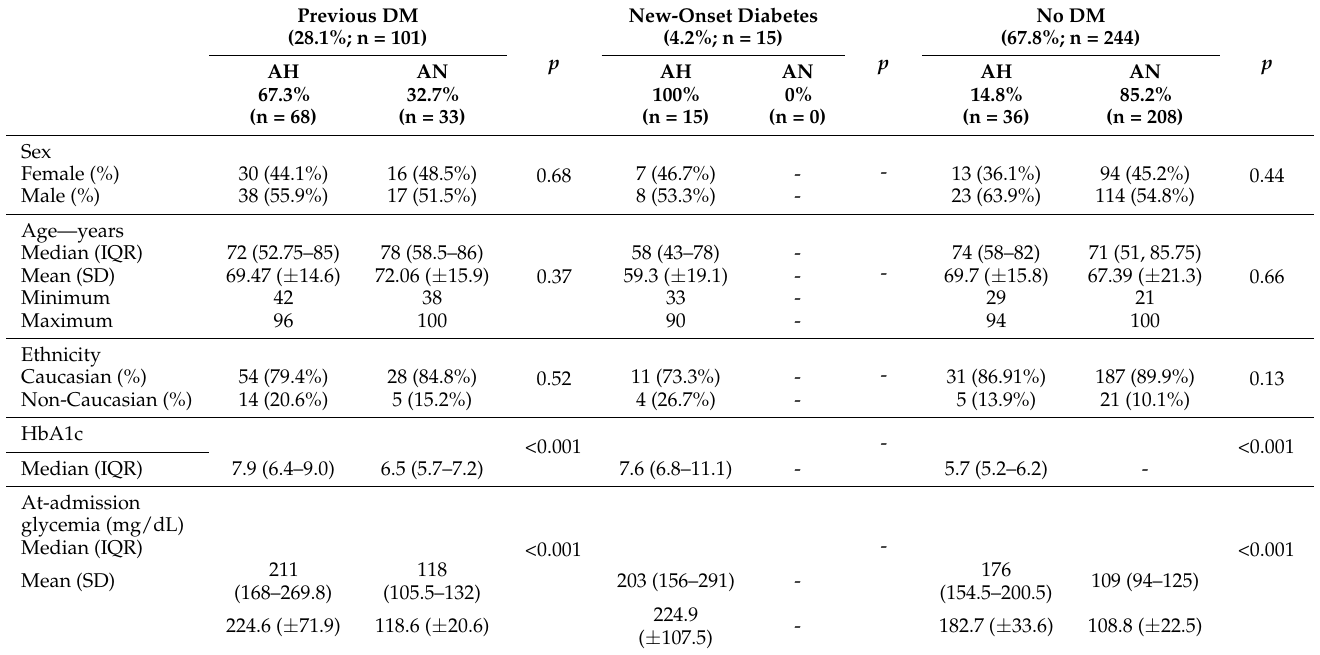
Table 3. Demographic and clinical variables of COVID-19 inpatients according to their glycemic